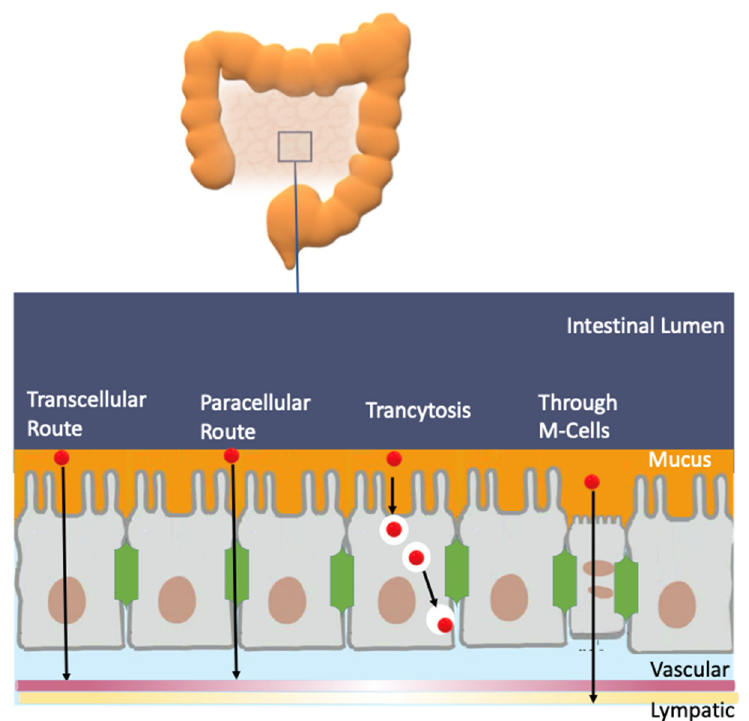
Figure 15. Schematic illustration of intestinal NDDS absorption. Transport of free drugs is inhibited via the epithelial cell membrane, viscous mucus layer and intercellular tight junction. Gastrointestinal enzymes and ABC efflux pumps also decrease the intestinal absorption. Possible absorption pathways for NDDS are shown by arrows. Table 8. Selected studies on NDDS-based formulations for improving the oral bioavailability of antioxidants.